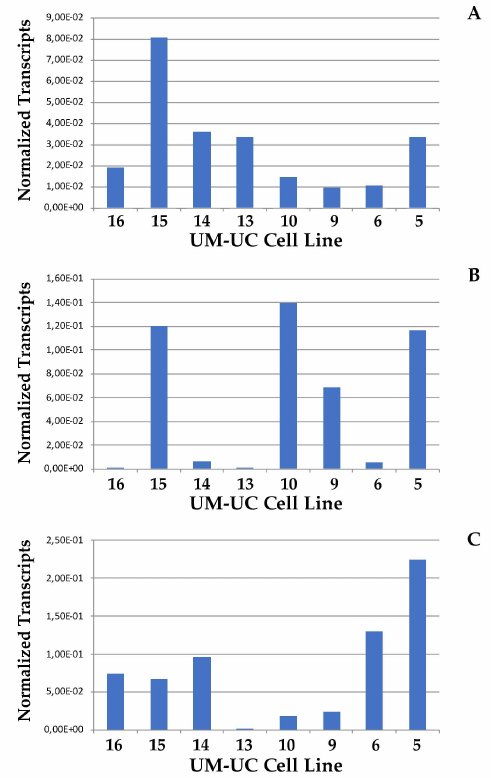
Figure 5. Expression of bladder cancer stem cell markers on UM-UCs. Expression of stem cell marker ( A ) ALDH1-A1, ( B ) CD24, and ( C ) CD44 was explored on transcript levels by RT-qPCR in UM-UC cell lines as indicated. The data document a representative analysis of target gene expression normalized to the respective housekeeping